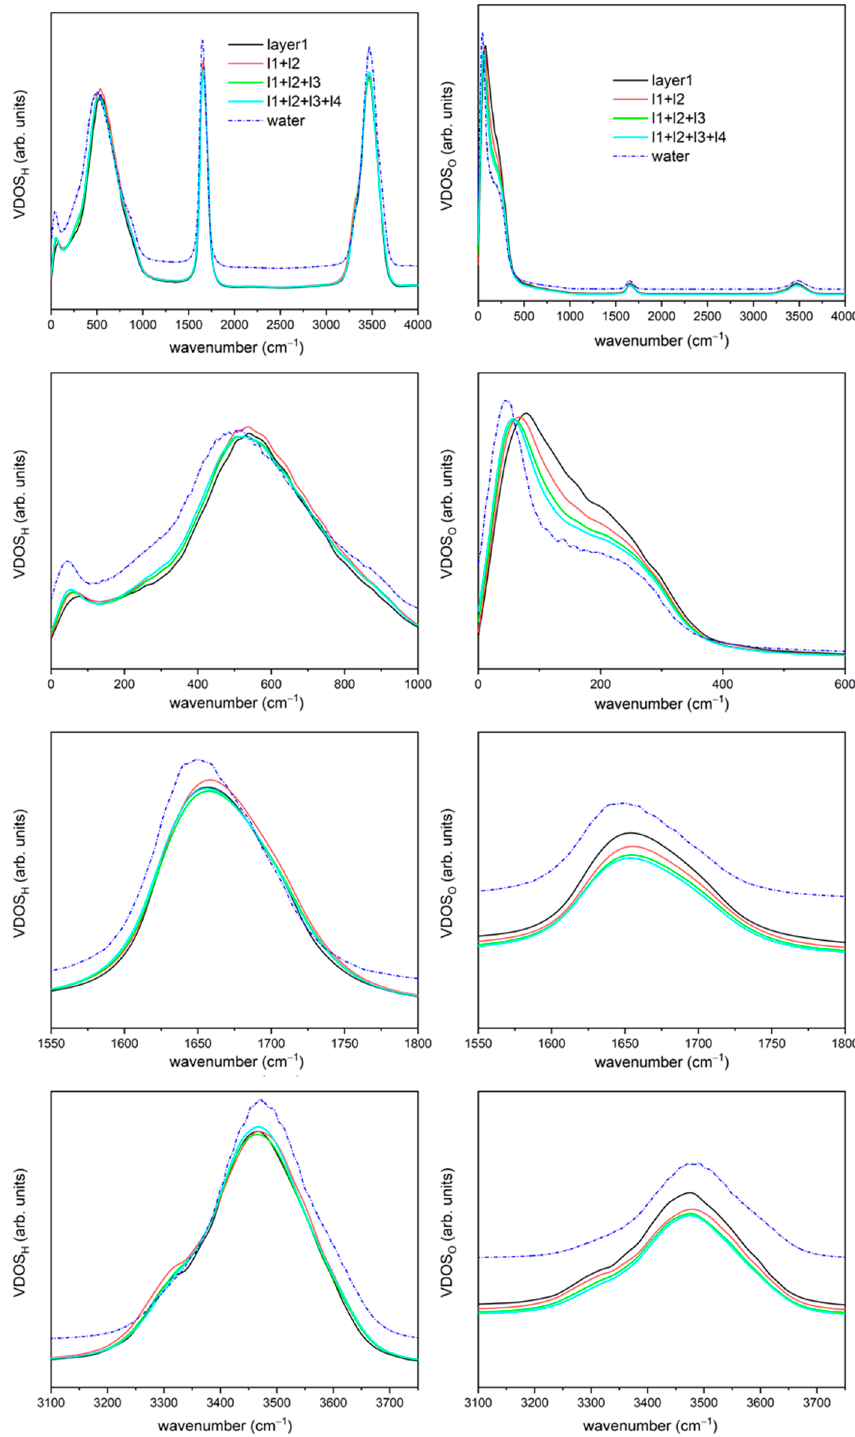
Figure 3. Vibration densities of states for hydrogen ( left ) and oxygen ( right ), for the water interfaces with one (black), two (red), three (green) and four (light blue) solvation layers in contact with the ubiquitin and liquid water (blue, line-dot-line). Full frequency range in the first row, the very low frequencies, e.g., acoustic, optic and librational regions, in the second row, H-O-H bending region in the third row and H-O stretching region in the fourth row.